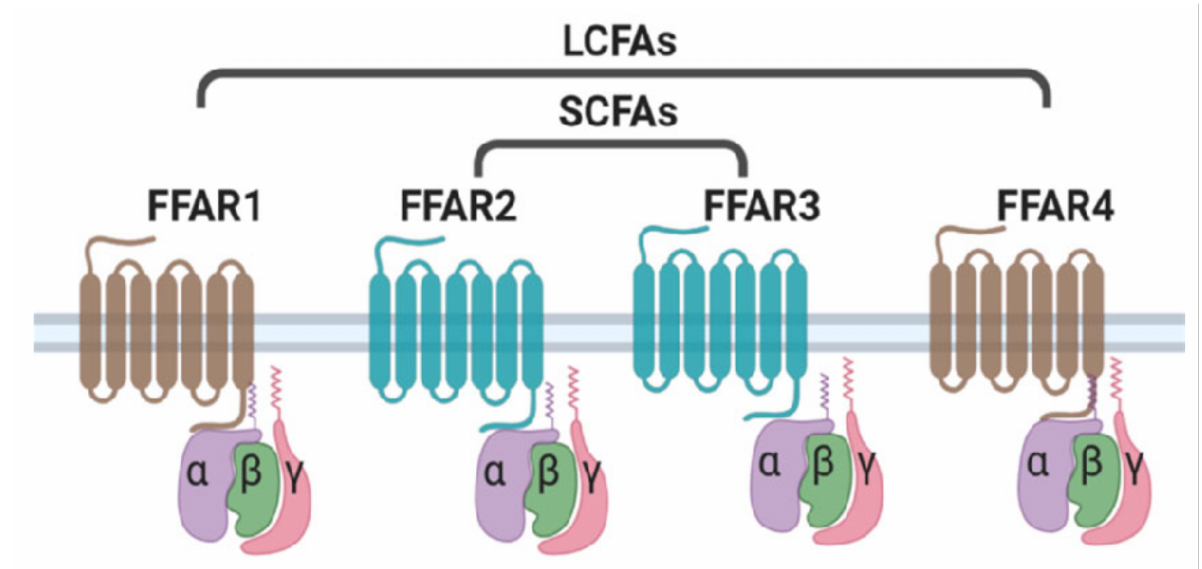
Figure 1. Ligand specificity of free fatty acid receptors. FFAR1 and FFAR4 act as receptors for long chain fatty acids (LCFAs), whereas short chain fatty acids (SCFAs) selectively activate FFAR2 and FFAR3.